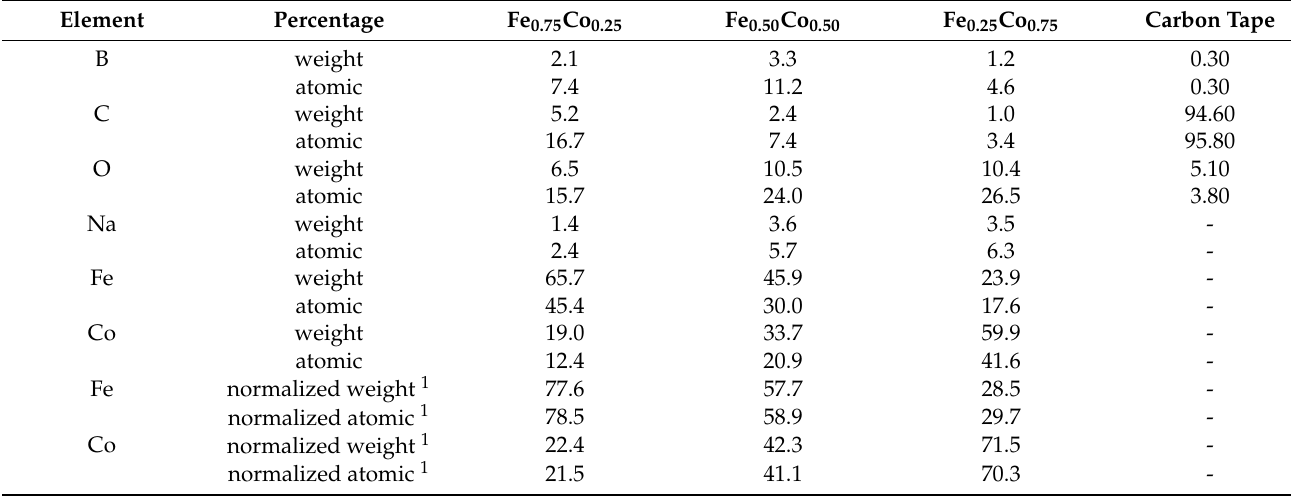
Table 1. Weight and atomic percentage of elements forming the as-prepared Fe 0.75 Co 0.25 , Fe 0.50 Co 0.50 , and Fe 0.25 Co 0.75 nanochains, and carbon type determined with EDS technique.